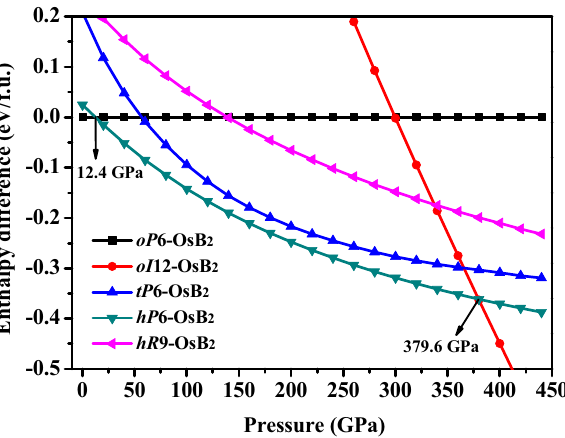
Figure 2. Enthalpy differences of predicted structures relative to oP 6-OsB 2 structure under high